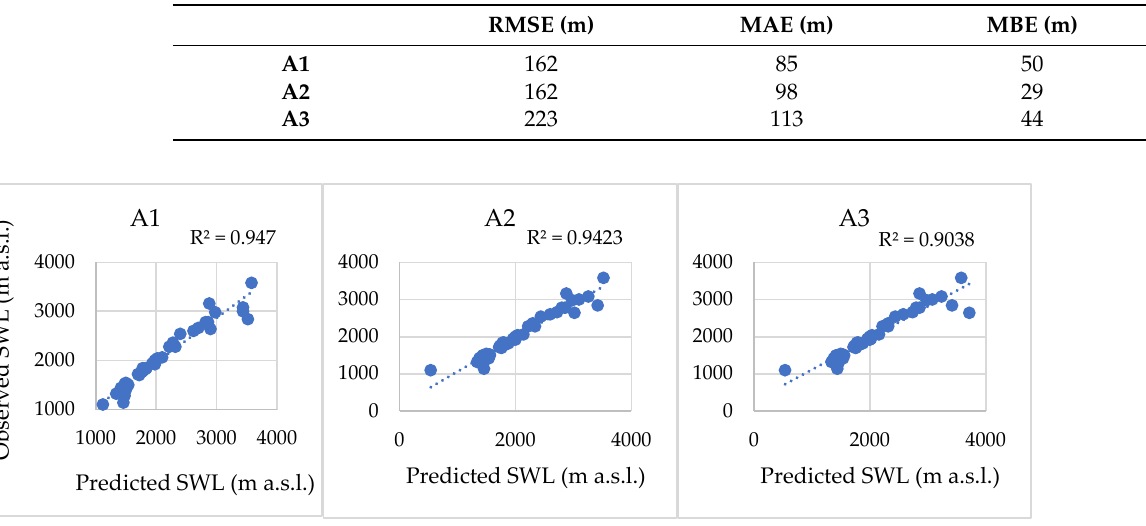
Figure 7 . Scatterplots of the predicted and observed snowline elevation (SWL) (m a.s.l.) for the three approaches ( A1 – A3 ).